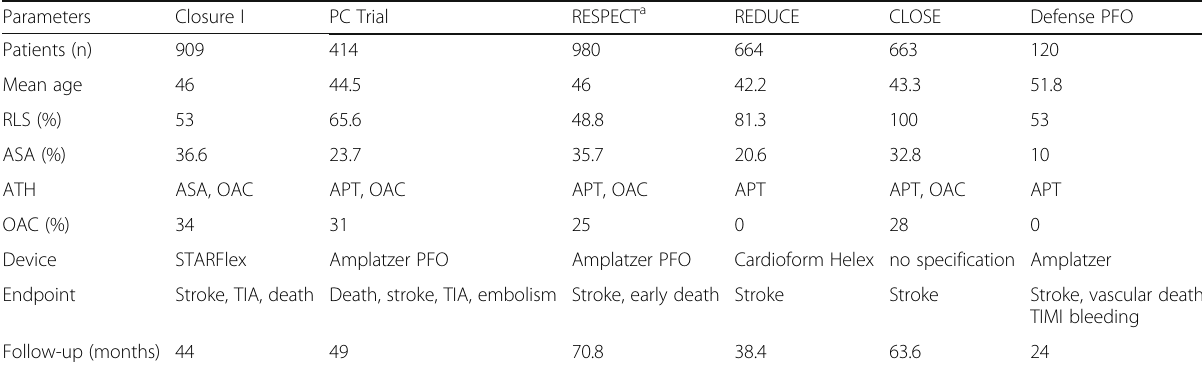
Table 1 Design and baseline data from the six randomised studies on PFO closure in cryptogenic stroke [9, 11, 23]